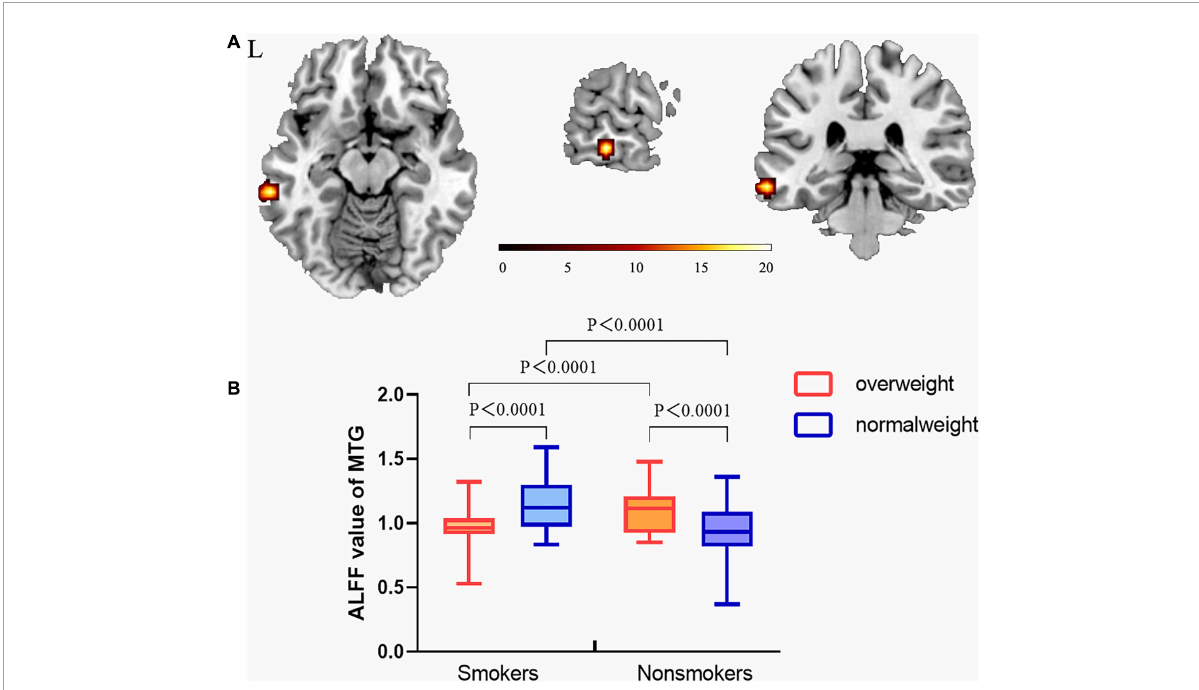
FIGURE2 The interaction effect between smoking and overweight. (A) A significant interaction effect shown by ALFF in the MTG using two-way ANOVA. The statistical significance level was set at voxel threshold P < 0.005 and cluster extent threshold P < 0.05, GRF corrected. (B) Post hoc analysis of the MTG among the four groups. From this figure, normal-weight smokers had increased ALFF value in middle temporal gyrus compared with normal-weight non-smokers. However, the ALFF value of the middle temporal gyrus of overweight smokers was still higher than that of normal-weight non-smokers, but the difference decreased. This suggests that the ALFF value of the middle temporal gyrus of overweight smokers is closer to that of normal-weight non-smokers, compared to that of normal-weight smokers. (The vertical bar indicates the maximum and minimum across subjects. The bars in the box represent the mean ALFF for each group.) “L” means the side is to the left.